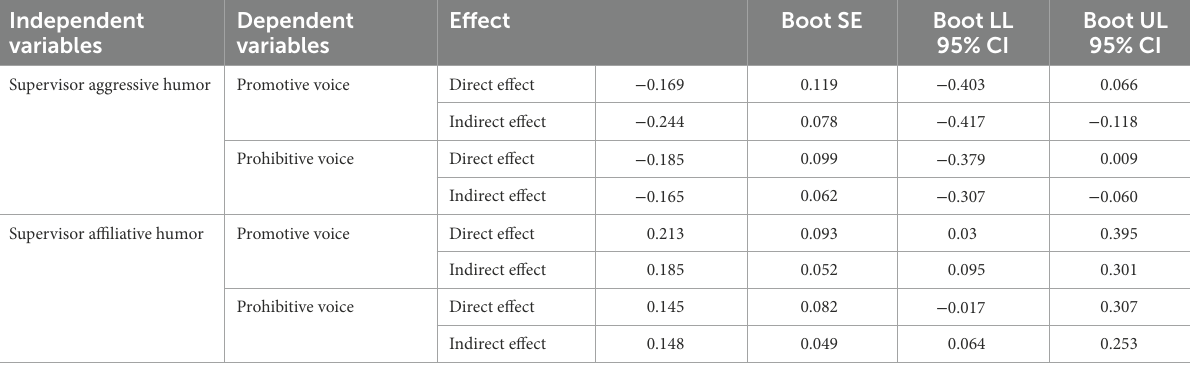
TABLE 3 Employees’ depletion as a mediator in the relationship between supervisor humor and voice behaviors. Independent